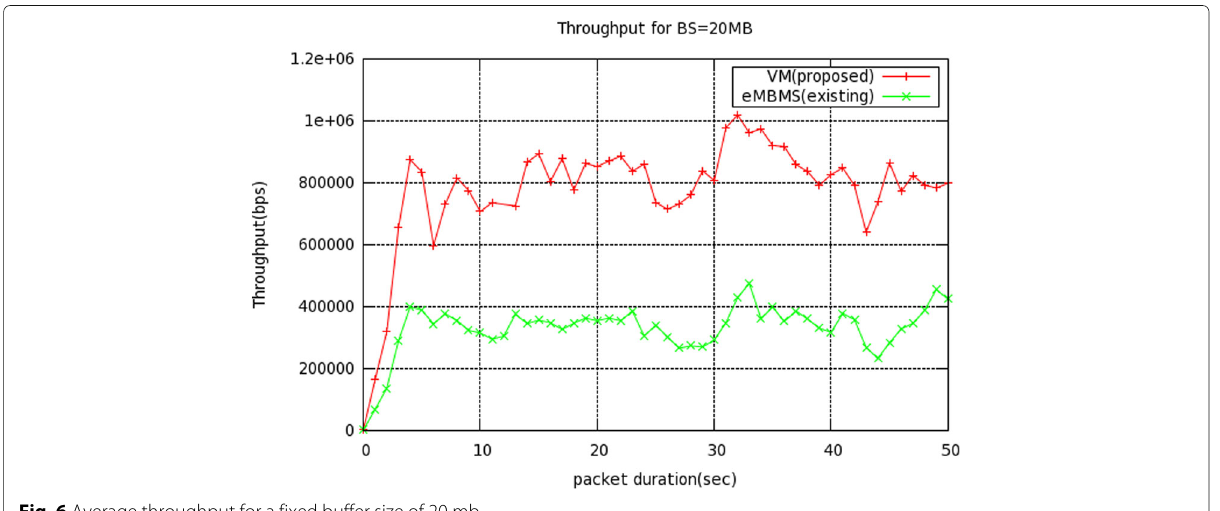
Fig. 6 Average throughput for a fixed buffer size of 20 mb